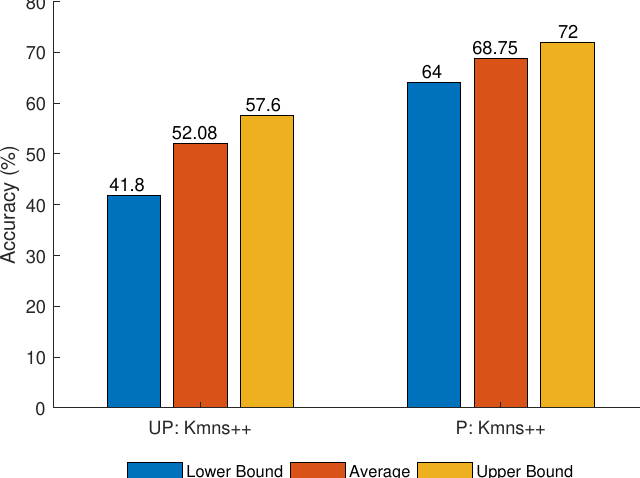
Figure 7. K-means++ accuracy for Simulation 2 parameters on unprocessed (UP) and preprocessed (P)